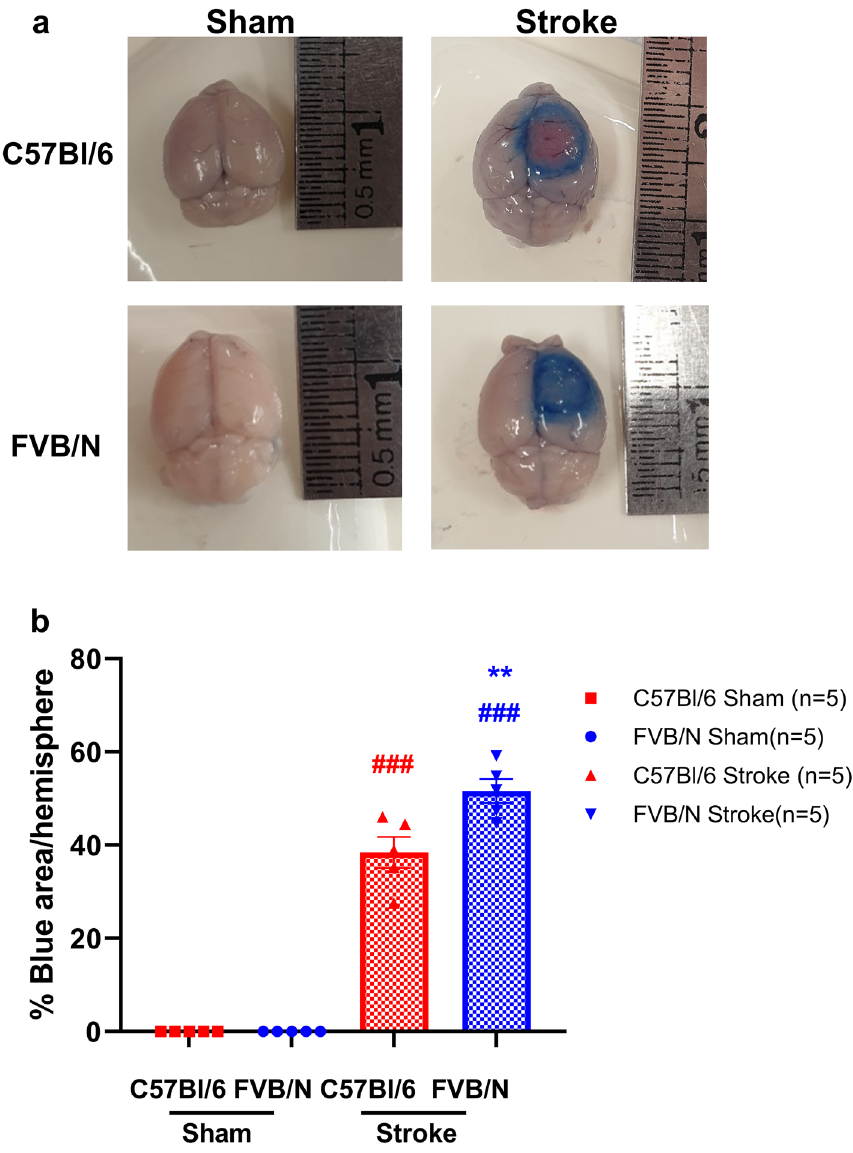
Figure 5. FVB/N mice have greater BBB breakdown compared to C57Bl/6 mice after 18 min of photothrombosis. Representative images ( a ) and quantification ( b ) of evans blue dye extravasation in the brain following 18 min of photothrombosis or sham surgery in the C57Bl/6 and FVB/N strains of mice. ### P < 0.001 vs sham, **P < 0.01 vs C57Bl/6, one-way ANOVA followed by Tukey’s multiple comparisons